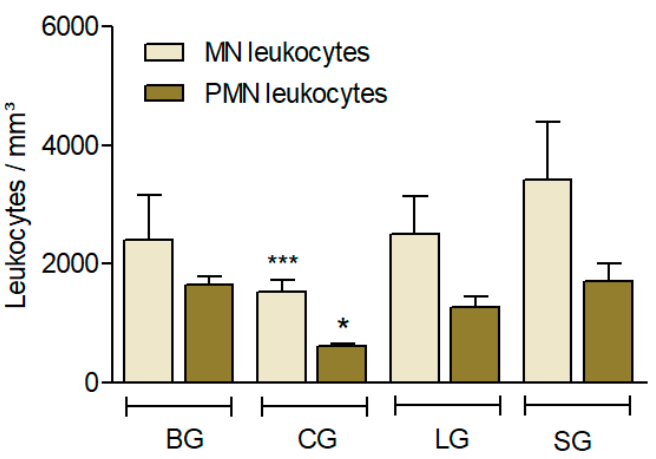
Figure 4. Effect of different diets (oils) on the leucocyte influx induced by Carrageenan (Cg). The animals received diet formulations of AIN for 60 days, with only the lipid sources modified (SG: soy oil, control; BG: baru oil; LG: linseed oil; CG: coconut oil). Four hours after the i.p. administration of Cg, the influx of (MN) and polymorphonuclear leukocytes (PMN) was evaluated. Results are expressed as the mean ± SD ( n = 6). ANOVA followed by a Bonferroni test. * p < 0.05; *** p < 0.001 (compared to the control, SG).